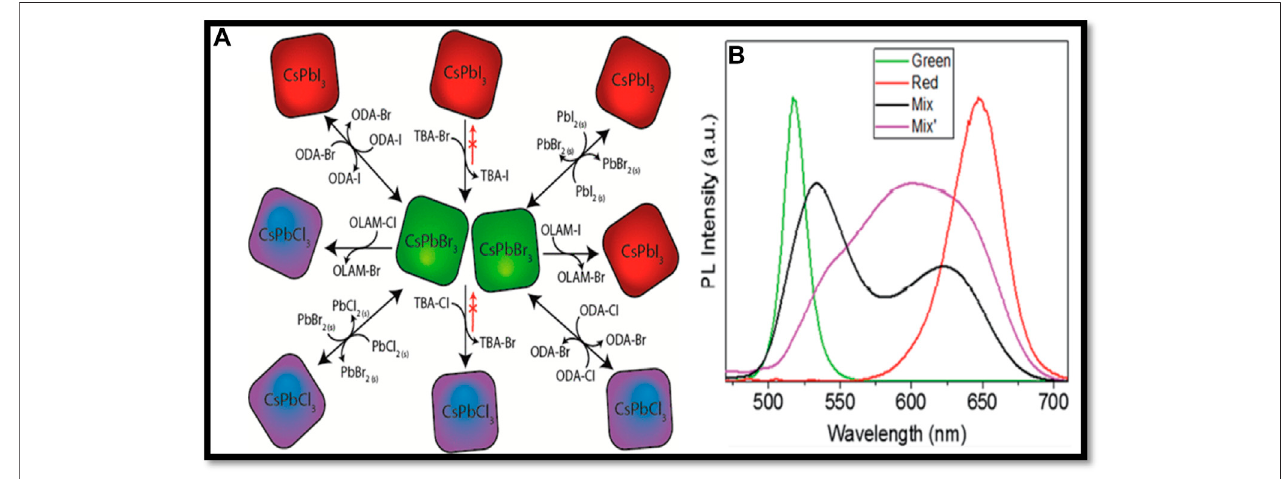
FIGURE 12 | (A) Schematic diagram of paths of halide anion exchange (Akkerman et al., 2015) and (B) spectrum of the initial mixture (purple line), mixture after 5 min (black line), and green and red perovskite quantum dots (Huang et al.,